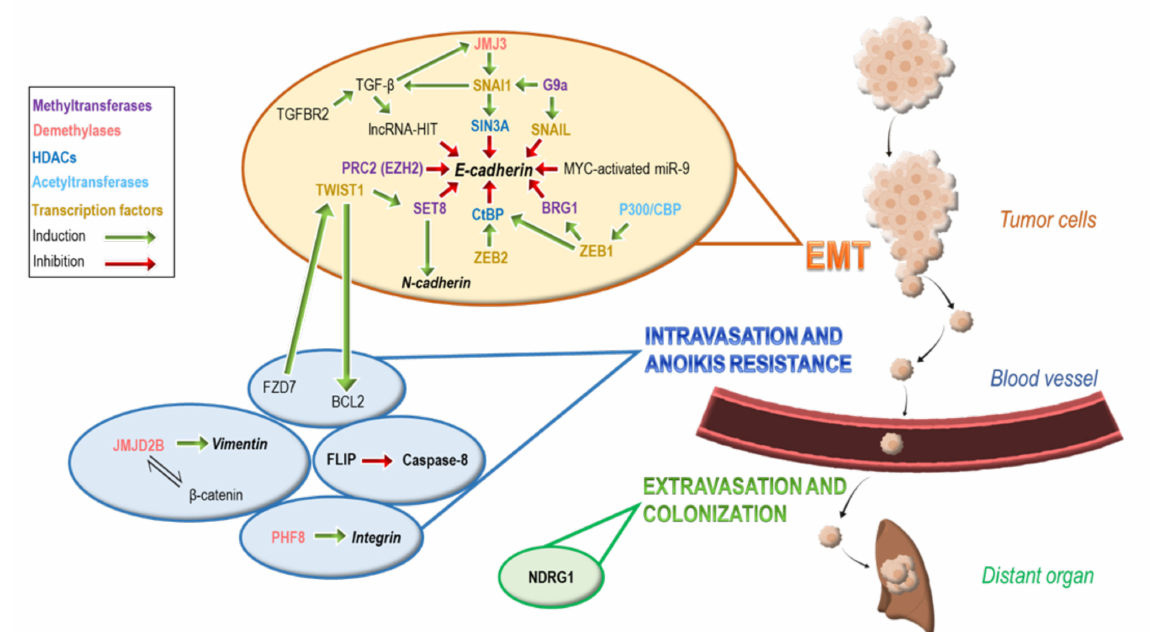
Figure 1. Epigenetic mechanisms regulate critical checkpoints of metastasis. Metastasis checkpoints are regulated by highly coordinated epigenetic mechanisms. EMT is mainly characterized by loss of E-cadherin expression. This can be achieved through regulation of transcription factors ZEB1, 2, SNAIL, and TWIST1. The p300/CBP complex acetylates the promoter of ZEB1, which further activates BRG1, in order to suppress E-cadherin via histone methylation. Additionally, ZEB1/ZEB2